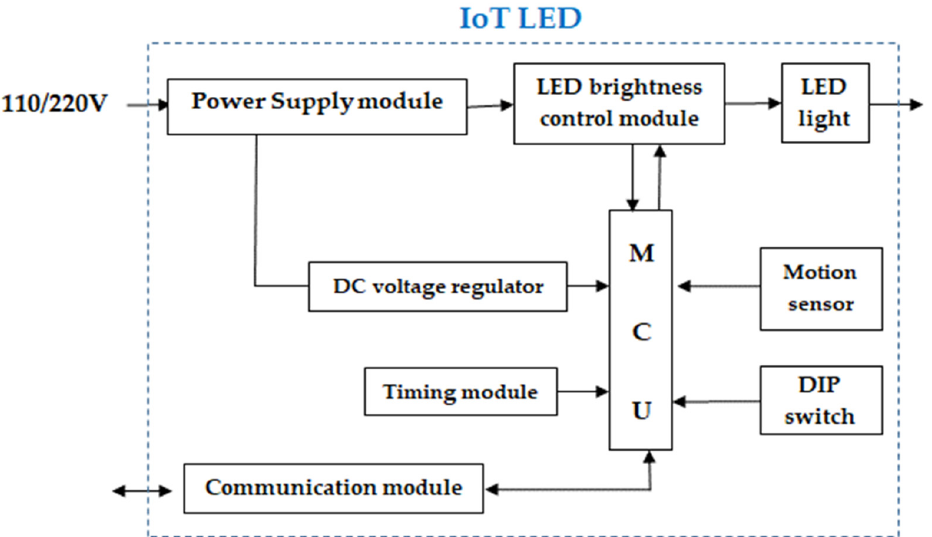
Figure 6. Hardware block diagram of the proposed IoT-based intelligent LED light (IoT LED).